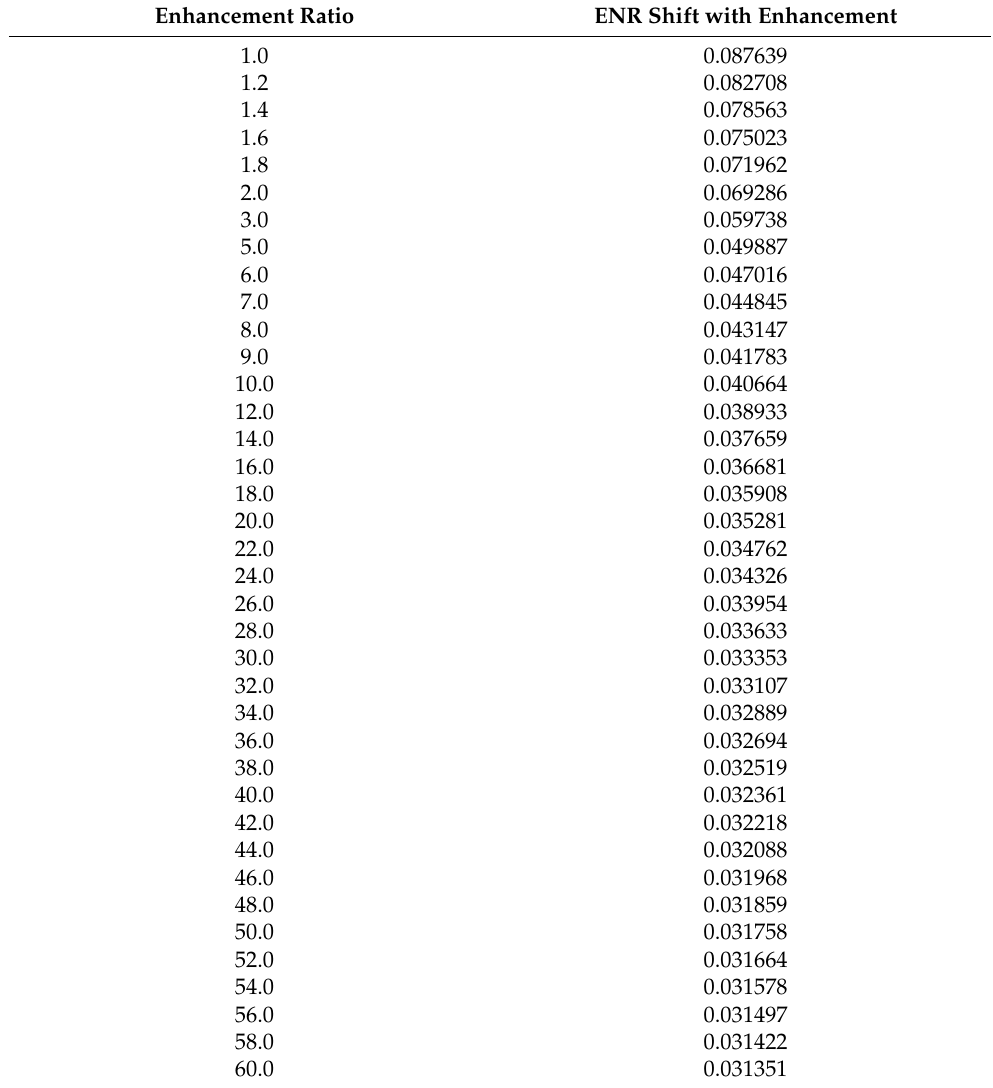
Table 2. ENR shifts at L = 0.35 λ with variable